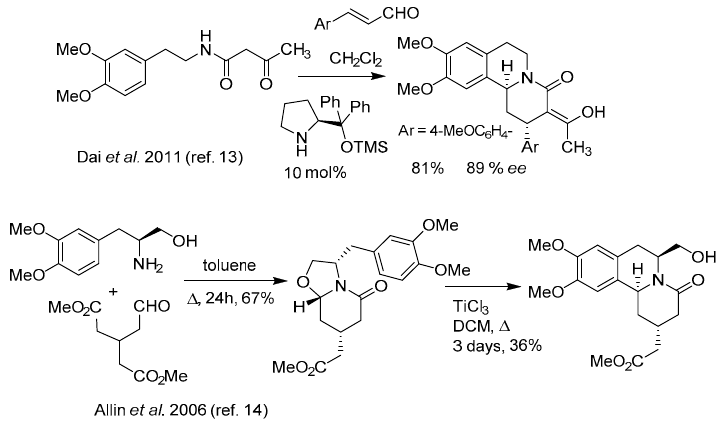
Scheme 1. Examples of reported asymmetric syntheses of